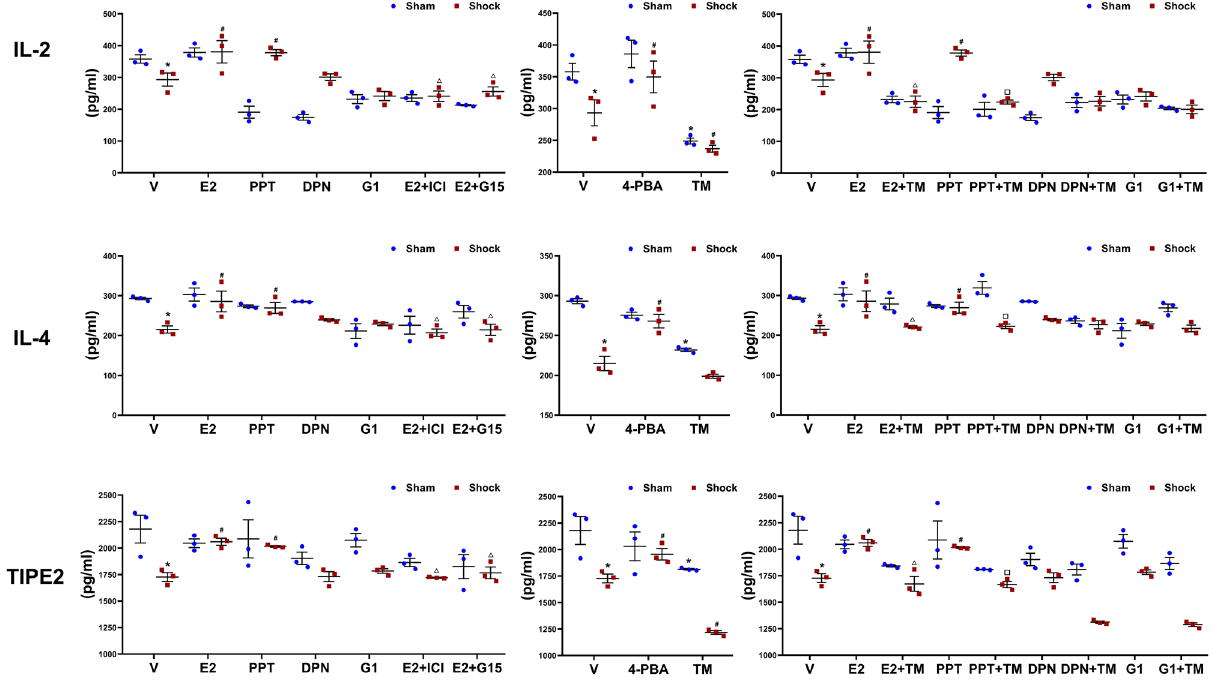
Figure 2. Cytokine production of splenic CD4 + T lymphocytes isolated from the rats. The CD4 + T lymphocytes were harvested from spleen in rats at 3 h after resuscitation or each time and treated with vehicle (V), 17-estradiol (E2), propyl pyrazole triol (PPT), diarylpropionitrile (DPN), G-1, E2 and ICI 182,780 (E2 + ICI), E2 + G15, 4-Phenylbutyric acid (4-PBA), tunicamycin (TM), E2 + TM, PPT + TM, DPN + TM, G-1 + TM, respectively. Subsequently, the CD4 + T lymphocytes were cultured in 96-well plates and stimulated with ConA (5 μg/ml) for 48 h, Cytokine levels of interleukin (IL)-2, IL-4, and tumor necrosis factor-α-induced protein 8 like 2 (TIPE2) in culture supernatants were determined by ELISA. Data are mean ± SE of 3 animals in each group. *p < 0.05 vs. the sham + vehicle group, #p < 0.05 vs. the shock + vehicle group, Δp < 0.05 vs. the shock + E2 group, □ p < 0.05 vs. the shock + PPT After incubation with Concanavalin A (ConA) for 48 h, the proliferative capacity of CD4 + T lymphocytes obtained from hemorrhagic shocked rats that received vehicle at the beginning of resuscitation was significantly decreased compared with that of sham-operated rats receiving vehicle in the presence of ConA (Fig. 1B). Admin- istration of E2 or ERα agonist propyl pyrazole triol (PPT) attenuated the suppressed proliferative capacity of splenic CD4 + T lymphocytes under hemorrhagic shock conditions, but there were not statistical changes follow- ing ERβ agonist diarylpropionitrile (DPN) or GPR30 agonist G1 treatments (Fig. 1B). In contrast, administrations of ER antagonist ICI 182,780 or GPR30 antagonist G15 abolished the effect of E2 on splenic CD4 + T lymphocytes proliferation capacity (Fig. 1B). The treatment of ERS inhibitor 4-Phenylbutyric acid (4-PBA) significantly inhibited the hemorrhagic shock- induced suppression of CD4 + T lymphocytes proliferation. In contrast, ERS inducer tunicamycin (TM) admin- istration reduced the proliferative capacity of CD4 + T lymphocytes harvested from the sham rats, and further aggravated the adverse effect of hemorrhagic shock inhibiting CD4 + T lymphocytes proliferation to a certain degree, but no statistical difference (P = 0.070) (Fig. 1C). Furthermore, the TM administration abolished the favorable effects of E2 or PPT on proliferation capacity of splenic CD4 + T lymphocytes isolated from hemor- rhagic shocked rats (Fig. 1D). Cytokine production of splenic CD4 + T lymphocytes. The CD4 + T lymphocytes were cultured in 96-well culture plates with ConA (5 μg/mL) for 48 h, and the cell culture supernatants were collected for the detection of interleukin (IL)-2, IL-4, and tumor necrosis factor-α-induced protein 8 like 2 (TIPE2). The results showed there were no significant differences in the IL-2, IL-4, and TIPE2 productions of splenic CD4 + T lym- phocytes without stimulation between sham and hemorrhagic shock (data not shown). The contents of IL-2, IL-4 and TIPE2 produced by splenic CD4 + T lymphocytes were decreased following trauma-hemorrhage, which were normalized by administrations of E2 or PPT, but not DPN or G1. Furthermore, administrations of either ICI 182,780 or G15 abolished the effects of E2 on splenic CD4 + T lymphocytes production of these cytokines (Fig. 2). In addition, 4-PBA significantly inhibited the cytokine productions of CD4 + T lymphocytes isolated from hemorrhagic shocked rats. TM reduced the cytokine productions of CD4 + T lymphocytes isolated from the sham rats and further aggravated the adverse effects of hemorrhagic shock. TM also counteracted the effects of E2 or PPT on the cytokines production of CD4 + T lymphocytes from rats with hemorrhagic shock (Fig. 2).